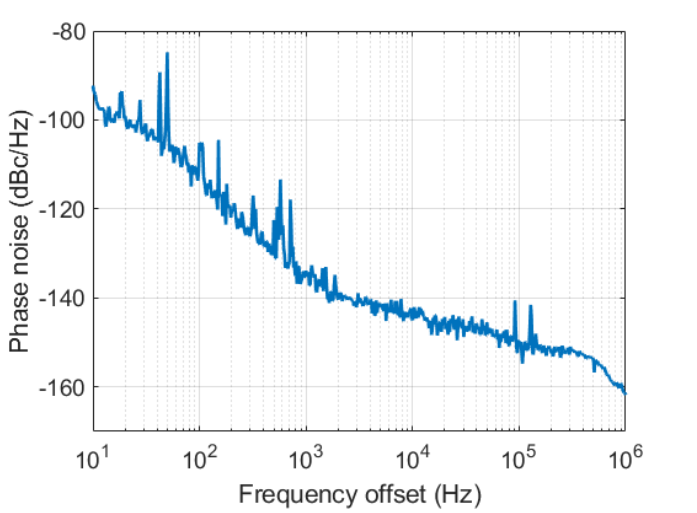
Figure 5. Phase noise of the 1.3 GHz reference signal generated with the Rohde and Schwarz SMA100B RF signal generator.